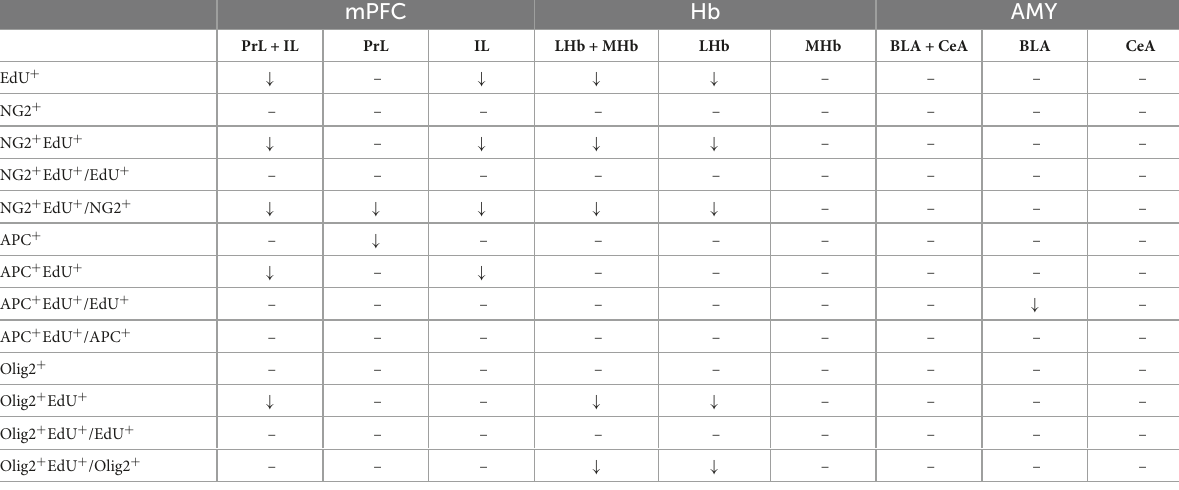
TABLE 1 The summary of the effect of CSDS on oligodendrogenesis in the mPFC, Hb, and